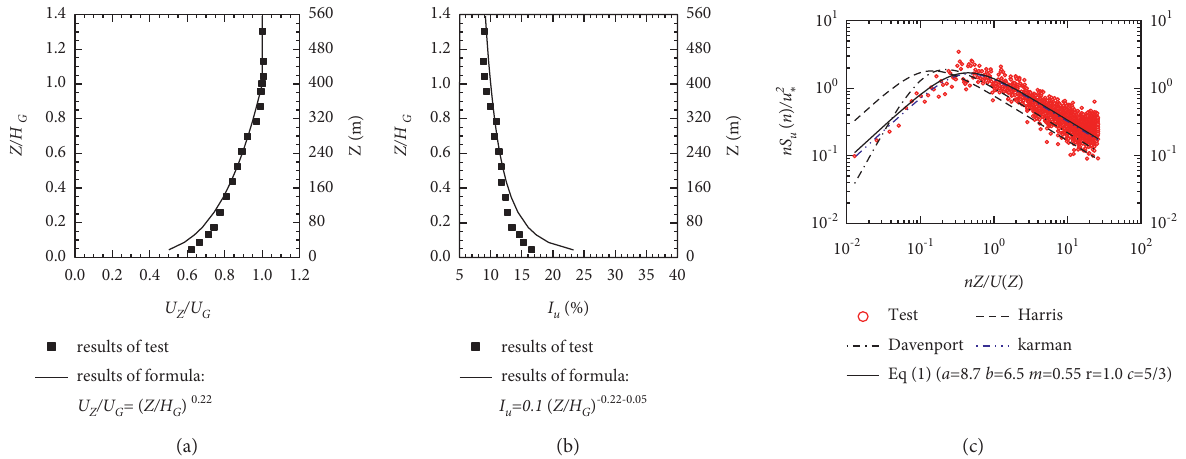
Figure 8: Experimental wind field characteristics. (a) Mean wind speed profile. (b) Turbulence profile of along-wind. (c) Fluctuating wind spectrum of along-wind.